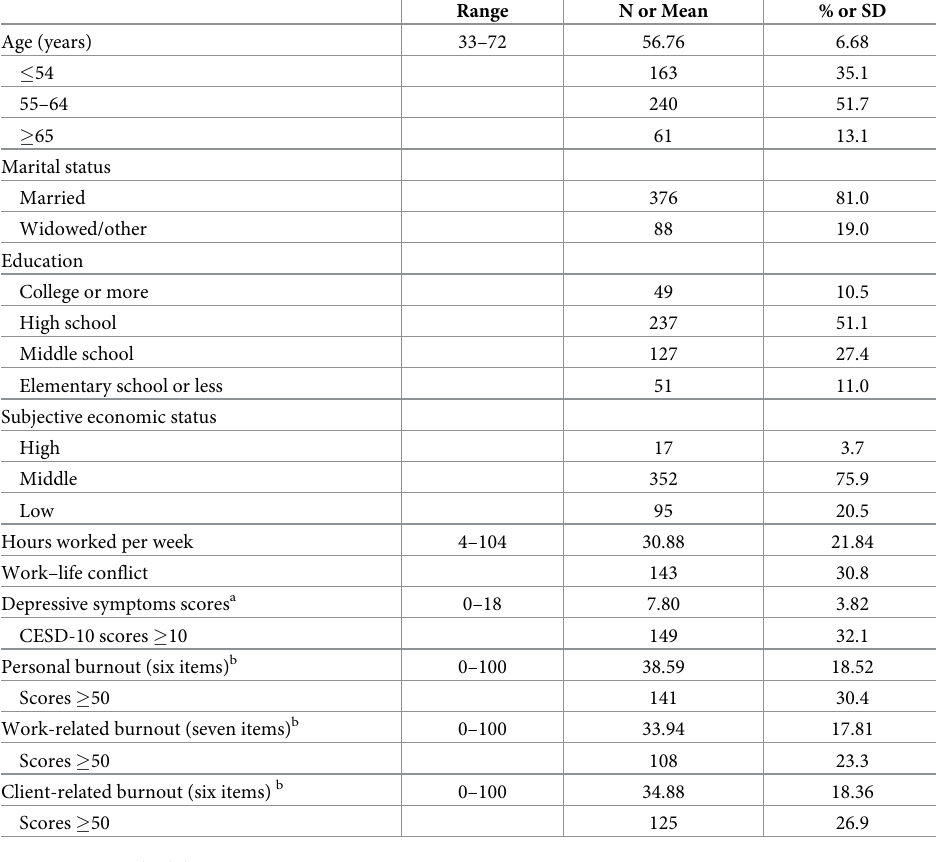
Table 1. Sociodemographic characteristics, depressive symptoms, and burnout among Korean homecare workers working with community-dwelling elderly individuals (N = 464).